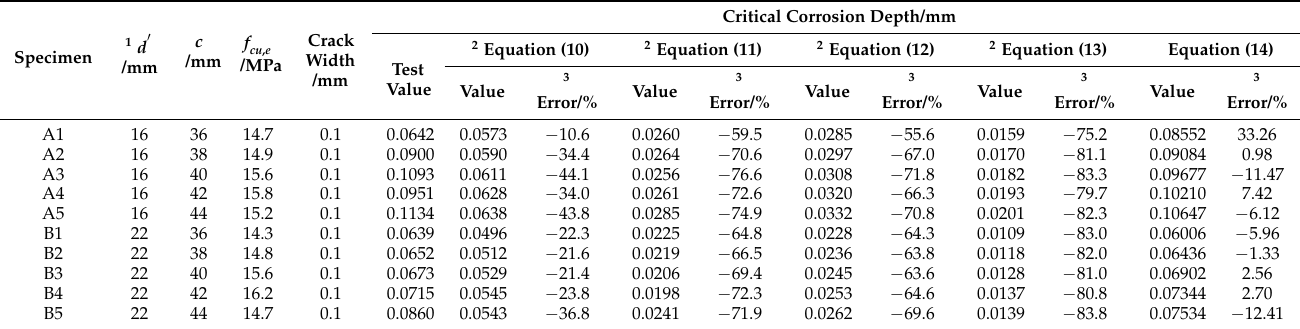
Figure 7. Schematic diagram of electrochemical accelerated corrosion test using the method of the parallel circuit. Table 3. Parameters of the specimens and test